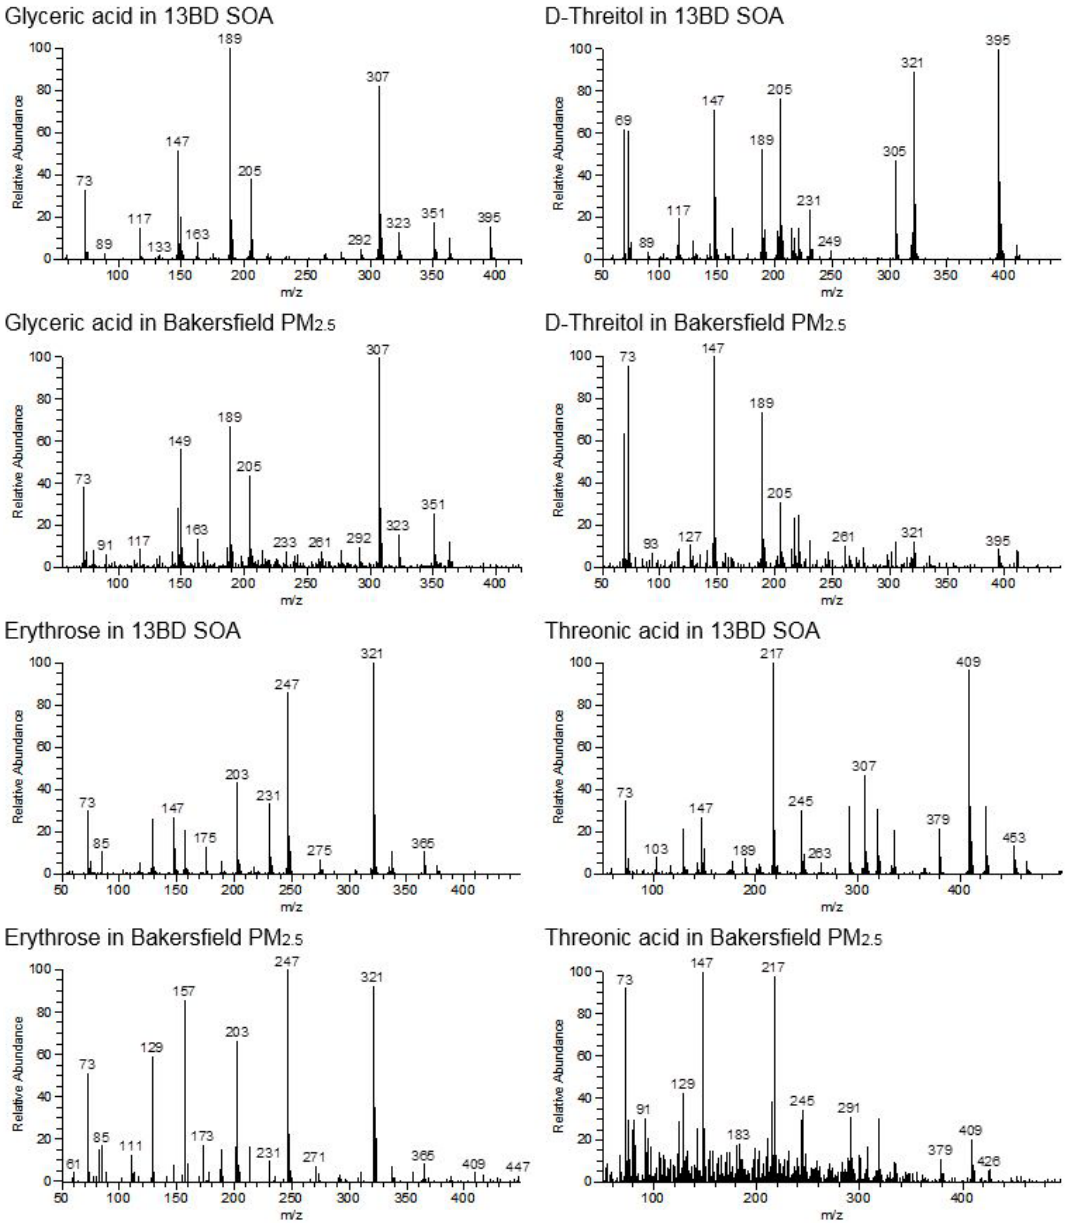
Figure 8. CI mass spectra of some organic compounds present in irradiated 1,3-butadiene/NO x /air and in ambient PM 2 . 5 extracts originating from a field sample from the western US (Bakersfield,